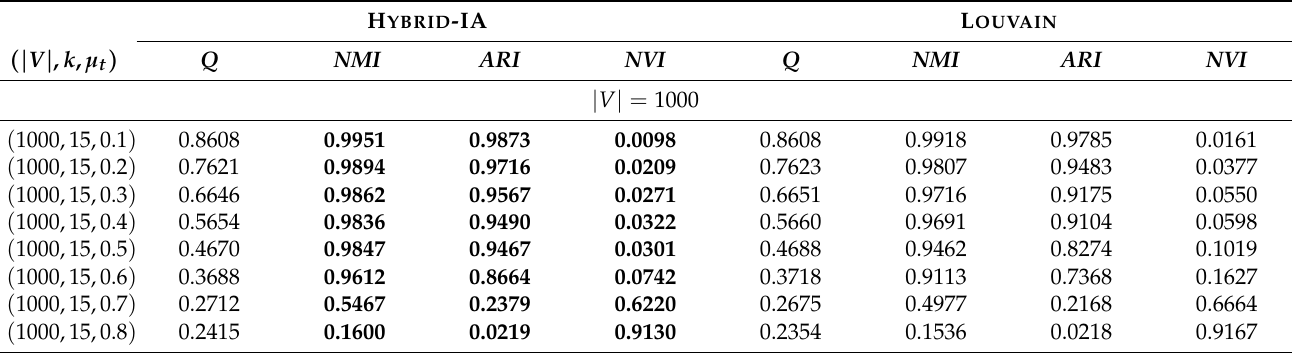
Table 4. H YBRID -IA functional sensitivity analysis on synthetic networks at different sizes: from 1000 to 10,000 vertices. NMI, ARI and NVI were considered as community structure similarity metrics. In boldface are reported the best obtained values. H YBRID -IA L